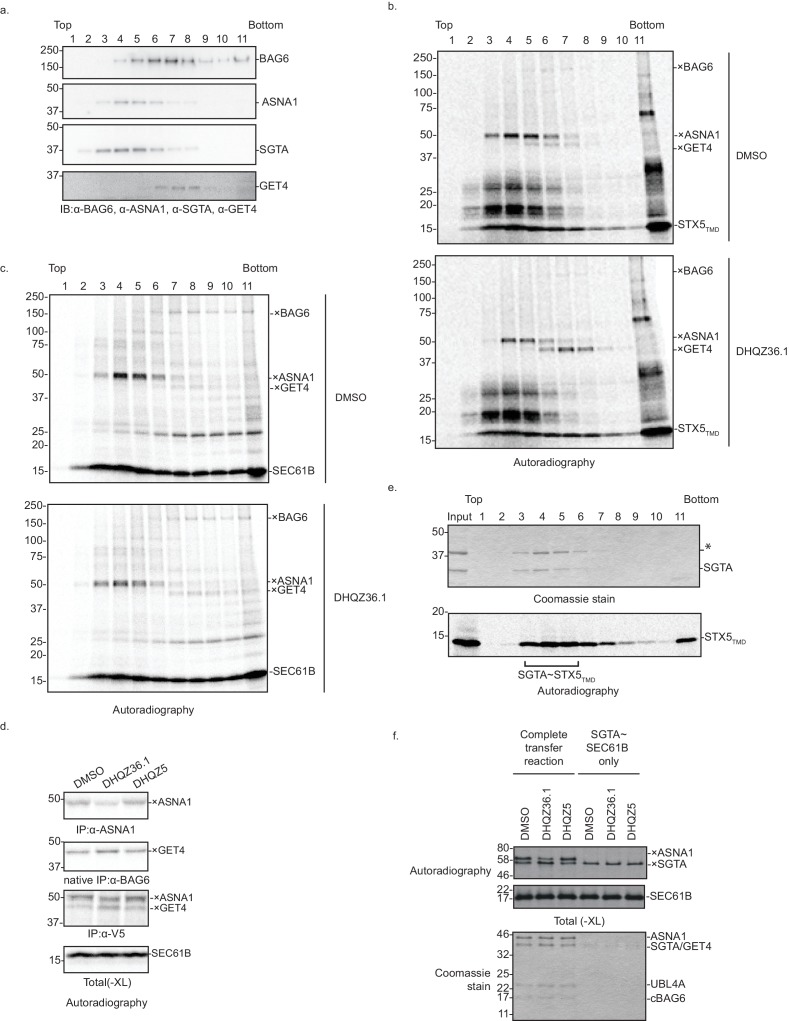
In vitro analysis of DHQZ36.1’s effect on ER targeting.(A) Crude RRL lysate was size-separated on a 5–25% sucrose gradient. The fractions were subjected to SDS-PAGE and visualized by immunoblotting for BAG6, ASNA1, SGTA, and GET4. (B) Uncropped version of the gels shown in Figure 5B. (C) In vitro translation of SEC61B in the presence of 35S-methionine and 15 µM DHQZ36.1 in crude rabbit reticulate lysate (RRL). Completed lysate reactions were subjected to size fractionation by centrifugation in a 5–25% sucrose gradient and their individual fractions chemically crosslinked with 0.250 mM bismaleimidohexane (BMH). Crosslinked samples were resolved by SDS-PAGE and visualized by autoradiography. Adducts to SEC61B are denoted with ×. (D) 35S-methionine-labeled SEC61B, which has C-terminal V5 epitope, was translated in crude RRL lysate in the presence of 15 µM of the indicated compounds. Translation reactions were subjected to chemical crosslinking (XL) with 0.250 mM BMH. Non-crosslinked samples were directly analyzed by SDS-PAGE. Crosslinked adducts to the TA protein substrate or ASNA1 were analyzed after denaturing immunoprecipitation (IP) with α-V5 or α-ASNA1 antibodies, respectively. For crosslinked products to GET4, samples were subjected to a non-denaturing IP with α-BAG6 antibody, which maintains the BAG6/GET4 interaction. Samples were visualized by autoradiography. Adducts to SEC61B are denoted with ×. (E) Representative data for SGTA~TA protein complex formation. In vitro translation of model TA substrate STX5TMD in the presence of 35S-methionine in PURE system supplemented with recombinant SGTA (final concentration of ~14 µM). Completed reactions were subjected to size fractionation by centrifugation in a 5–25% sucrose gradient. Fractions were analyzed by SDS-PAGE and visualized by Coomassie blue staining (top) and autoradiography (bottom). Fractions 3, 4, and five were pooled together and used as source of SGTA~STX5TMD in Figure 5E. * is a component of the PURE system (Mateja et al., 2015). (F) The complex of 35S-methionine labeled SEC61B and SGTA (SGTA~SEC61B) was generated using the PURE system. The transfer reactions were assembled with recombinant TRC pathway components in the presence of 15 µM of the indicated compounds and subjected to chemical crosslinking (XL) with 0.250 mM BMH. Samples were directly analyzed by SDS-PAGE, and autoradiography to visualize TA protein crosslinks (top), or Coomassie blue stain to detect the input proteins (bottom). Adducts to SEC61B are denoted with ×.